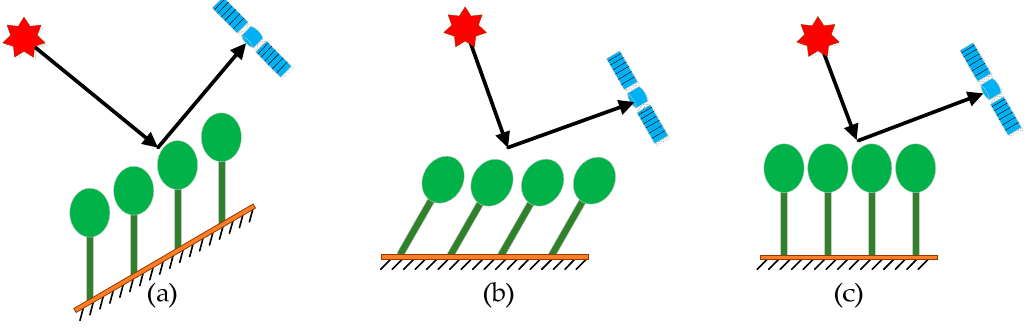
Figure 9. Topographic effects on crown sun-canopy-sensor geometry. ( a ) Forest stand on solo slope surface, ( b ) geometry correction without negative geotropism consideration, and ( c ) geometry correction with negative geotropism consideration.